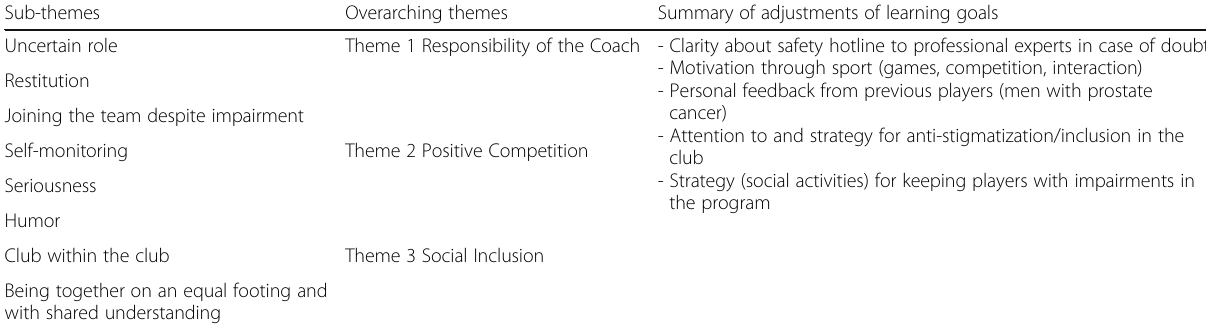
Table 4 Overview of findings in step 2